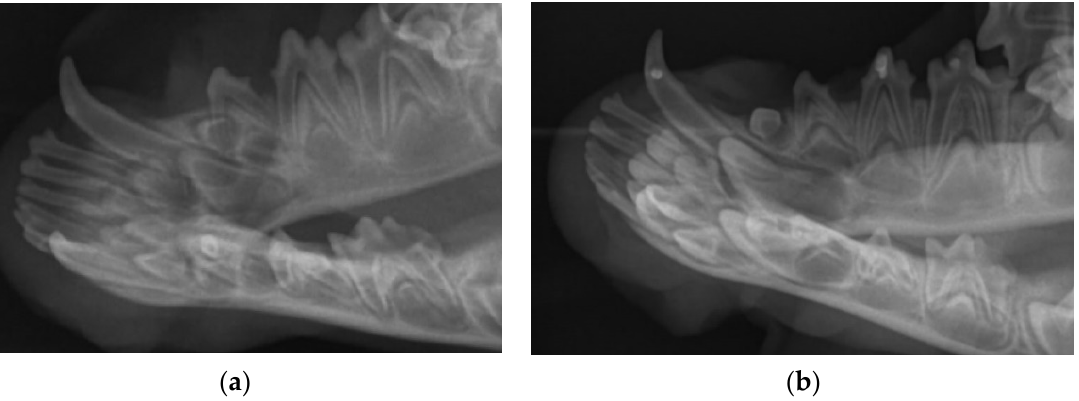
Figure 4. Radiographical image of the right mandible: ( a ) prior to DPC, ( b ) 14 days after DPC of teeth 804, 806 and 807.